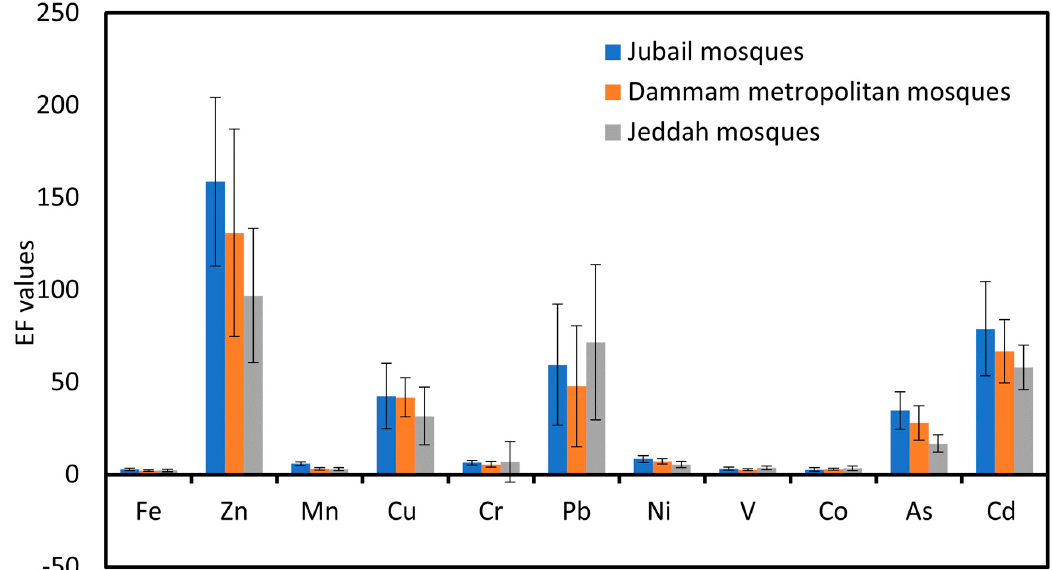
Figure 5. Enrichment factors analysis (EFs) of PHEs in ACFD of Jubail, Dammam metropolitan, and Jeddah mosques.